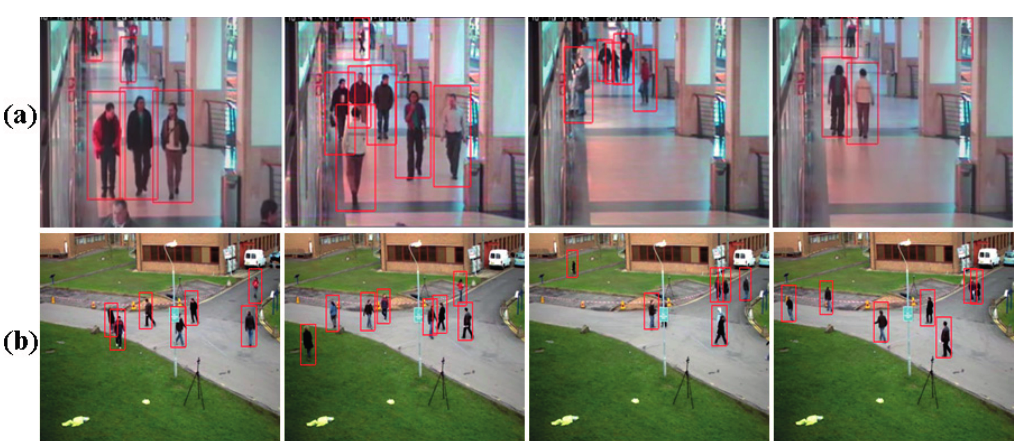
Figure 7. Sample human detection results of the proposed method using the ( a ) CAVIA and ( b ) PETS2009 test